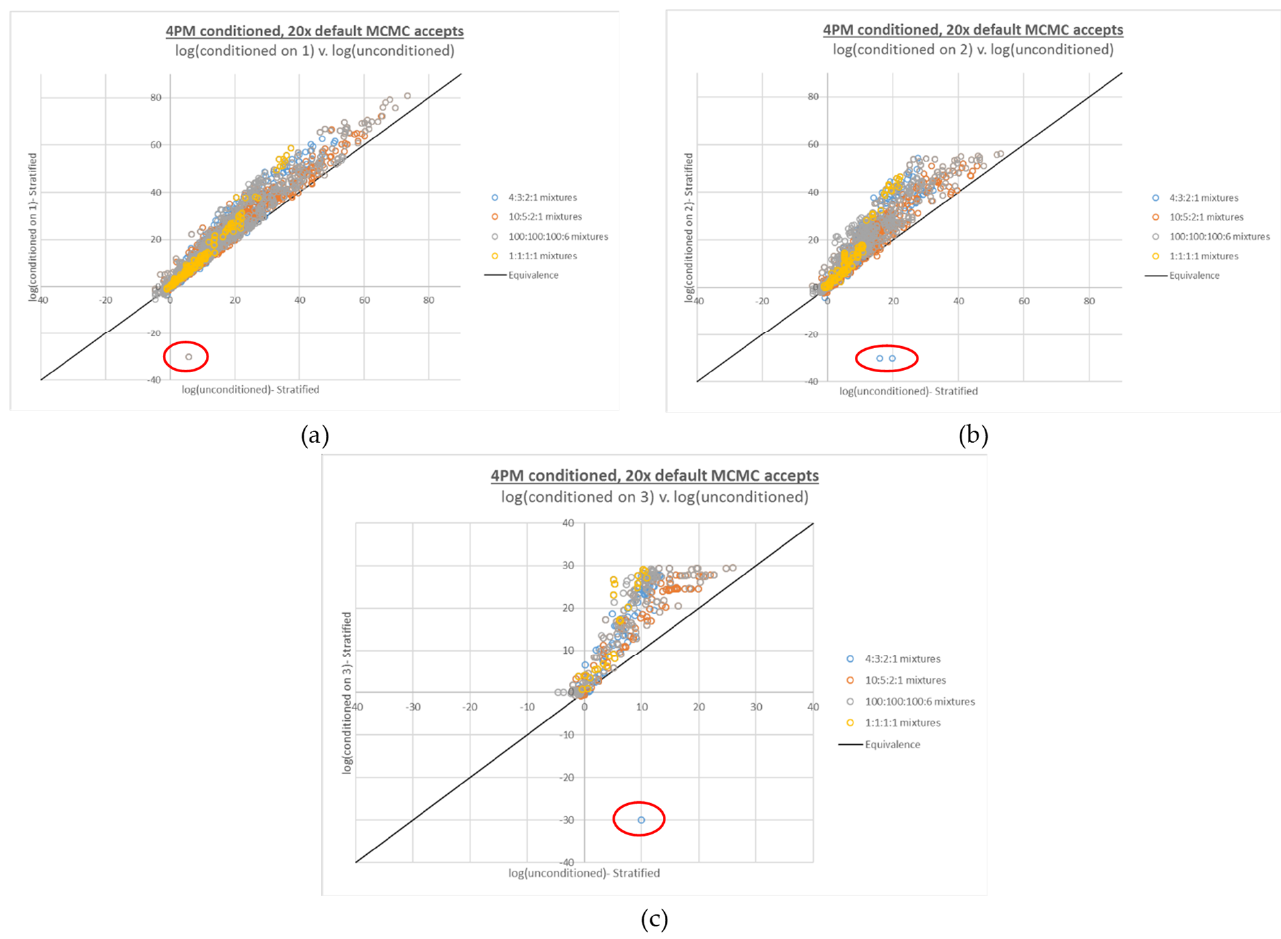
Figure 6. Four-person conditioned LR plots from Figure 5, recalculated based on interpretations run at 20x MCMC accepts. The number of conditioned true contributors are ( a ) 1, ( b ) 2, and ( c ) 3. A limited number of false negative LRs (LRs of 0, plotted at − 30 and circled in red) are still observed with 20x accepts.